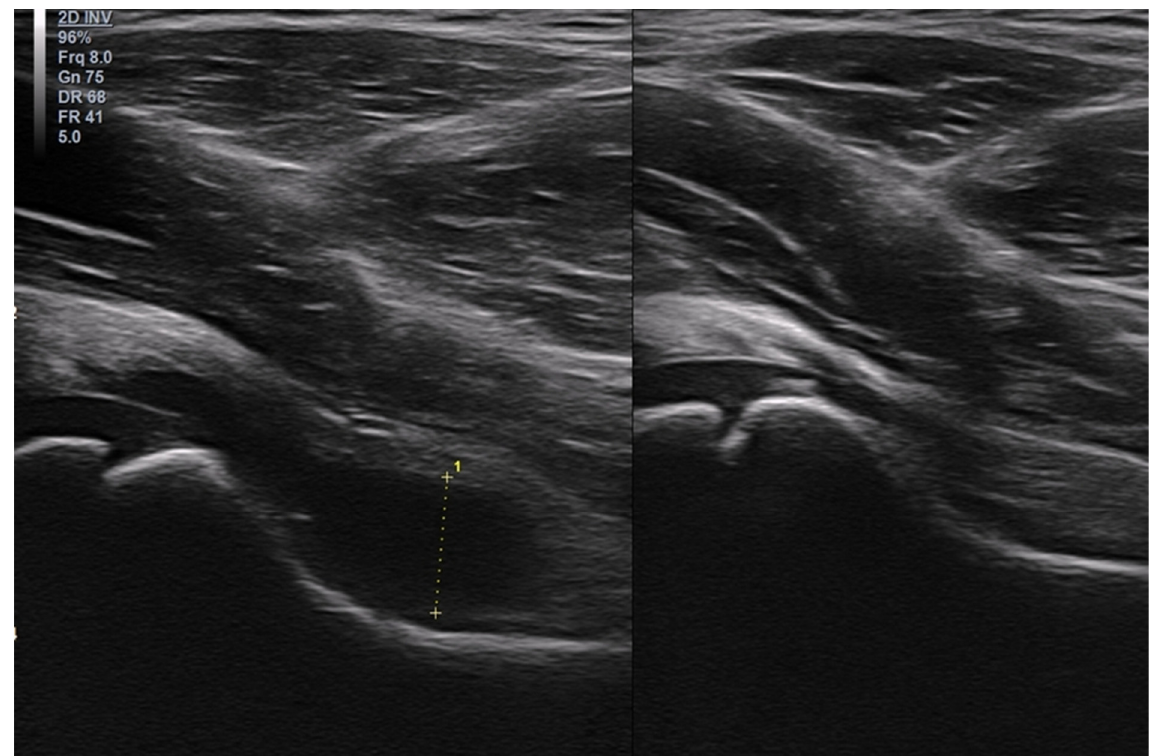
Figure 16. A case of transient inflammation of the right hip joint in a 5-year-old boy. Images in the plane of the long axis of the femoral neck. The exudate in the right hip joint is marked with a dotted line (left side of the image). A normal image of the healthy left hip joint (right). Linear probe 3–19 MHz.